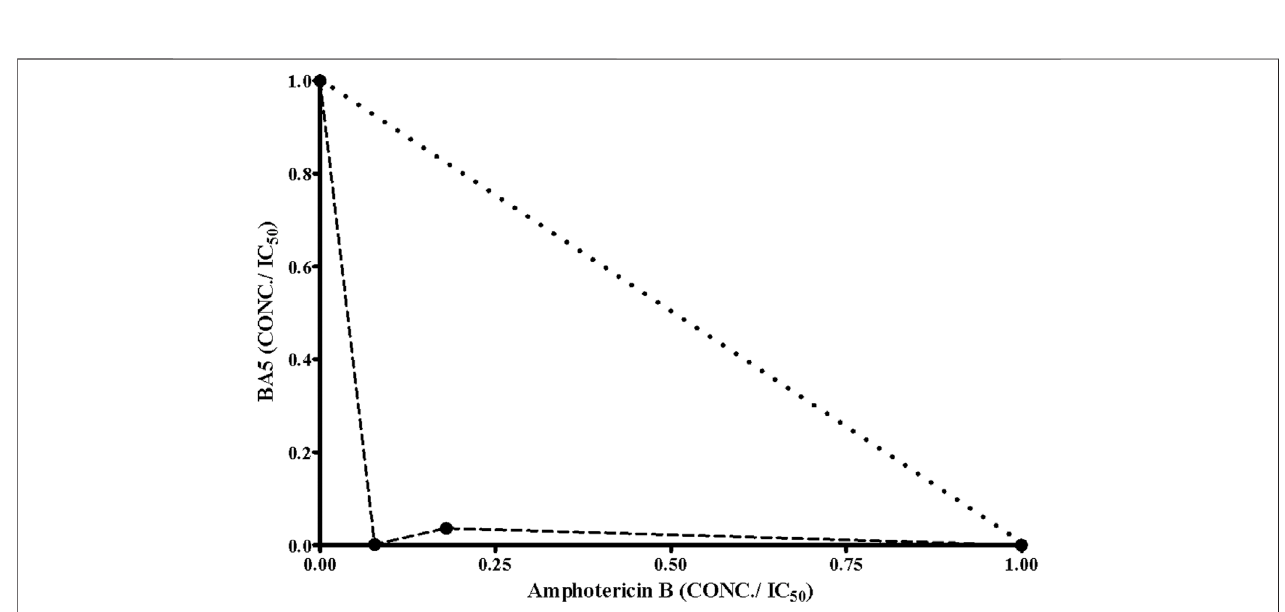
FIGURE 7 | Isobologram showing the synergistic effects between BA5 and amphotericin B on L. amazonensis promastigotes. Broken lines correspond to the predicted positions of the experimental points for additive effects.